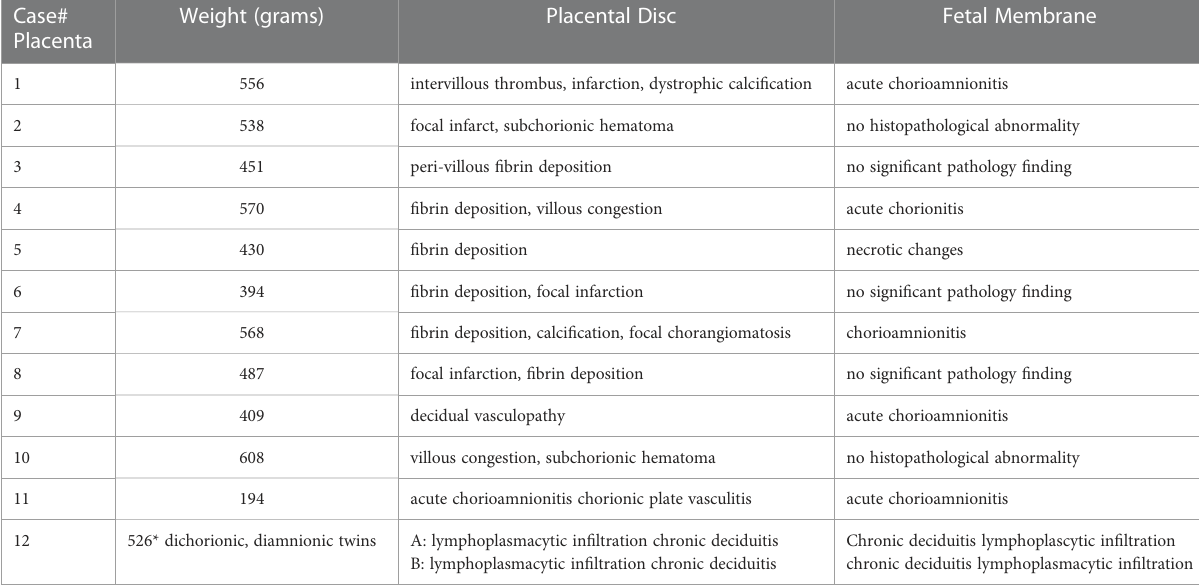
TABLE 3 Placental microscopic pathology of COVID-19